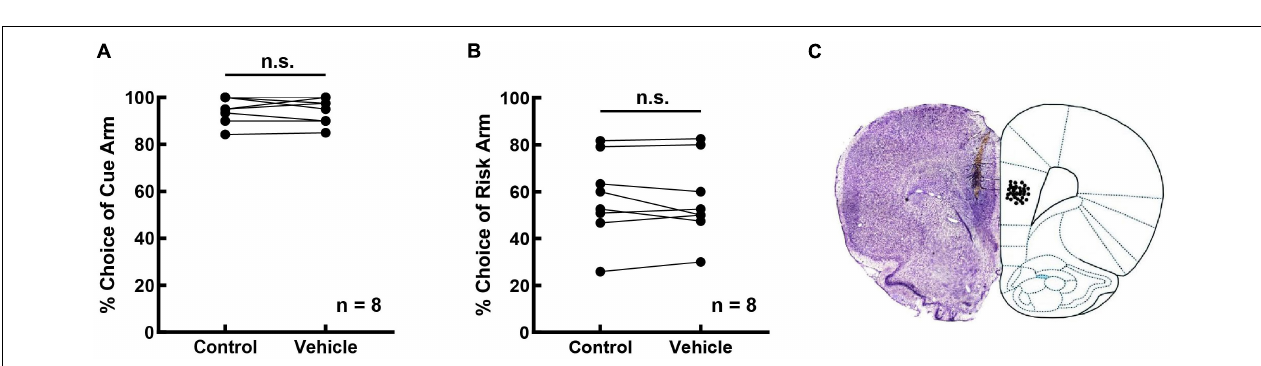
FIGURE 4 | Prefrontal D2 receptors are involved in regulating cue-guided RDM behavior. (A) Bilateral infusion of the D2 antagonist thioridazine into the mPFC did not affect rats’ performance in the cue-test blocks. (B) Risk selection in the free-choice block was increased upon inhibition of D2 receptors in the mPFC. (C) Bilateral infusion of the D2 agonist MLS1547 into the mPFC did not affect rats’ performance in the cue-test blocks. (D) Risk selection in the free-choice block was reduced upon stimulation of D2 receptors in the mPFC. ** p < 0.01; *** p < 0.001.